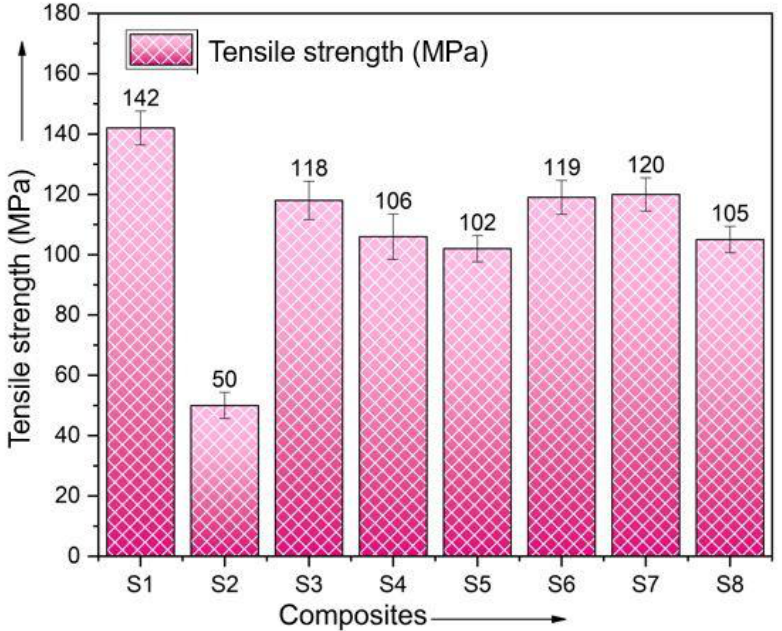
Figure 8. Comparison of tensile strength.